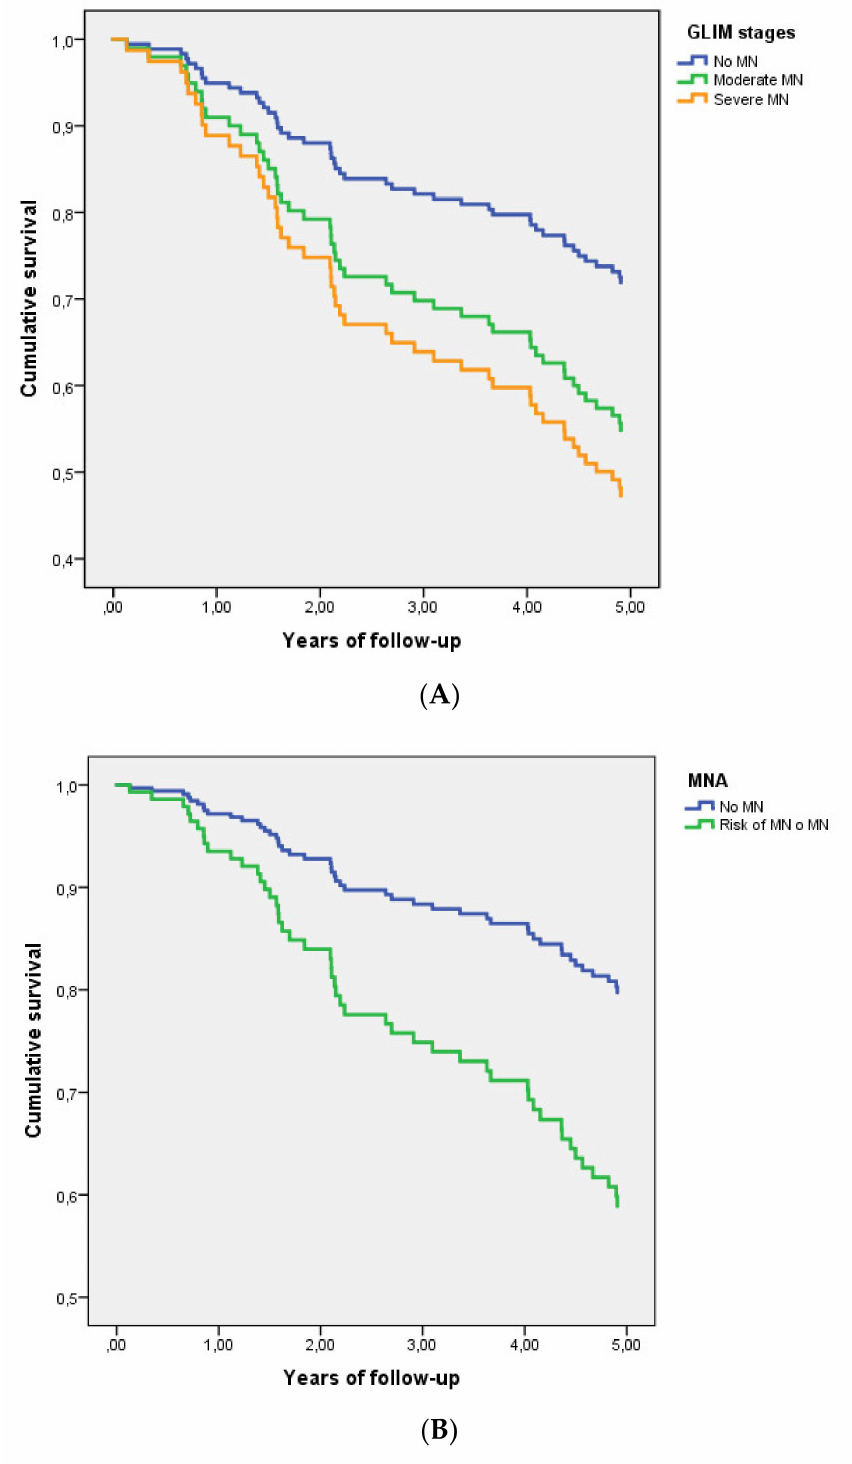
Figure 2. Survival curves ( A ) according to the three categories of nutritional status by the GLIM crite- ria and ( B ) MNA merged categories of nutritional status (normal nutrition and abnormal nutritional status) in outpatients with